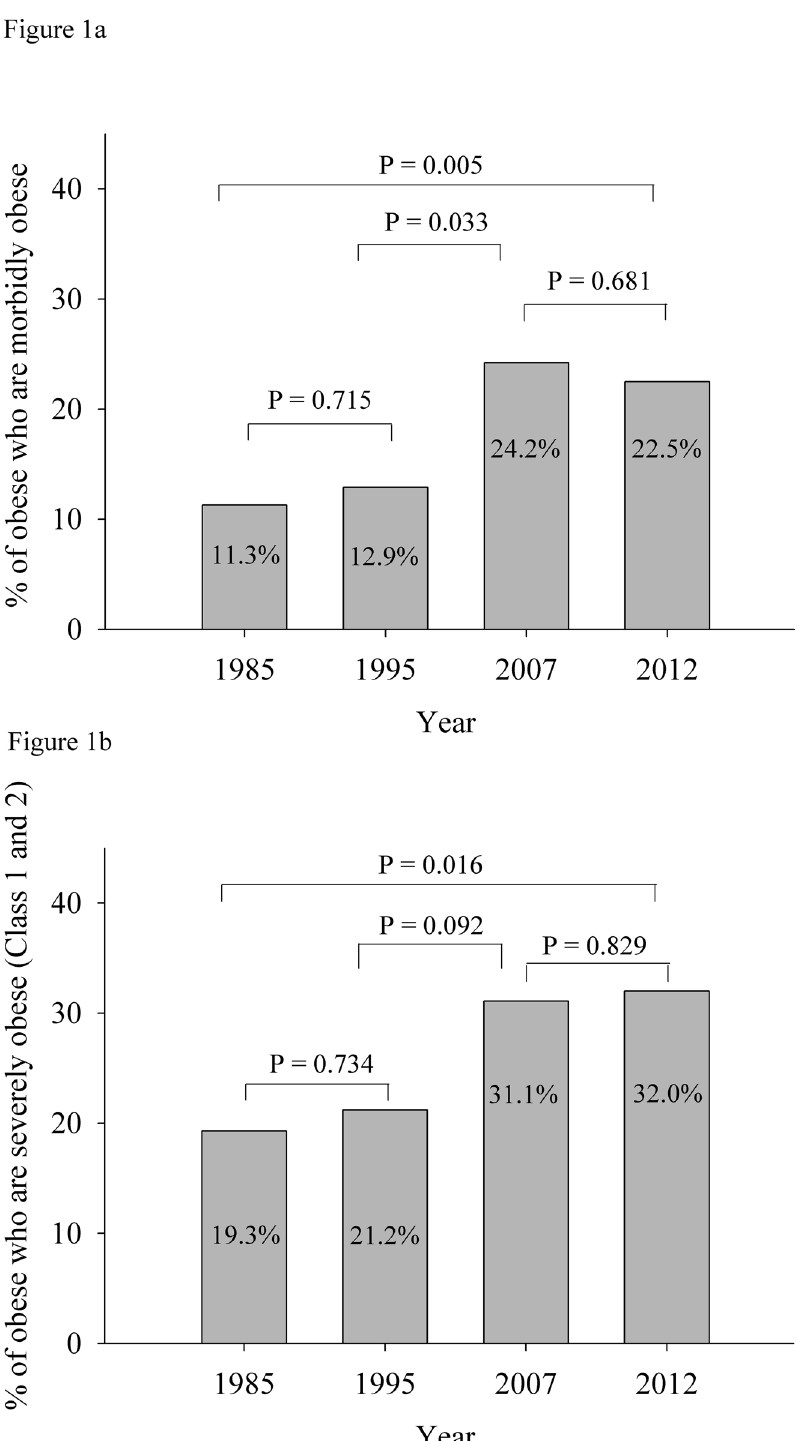
Fig 1. Prevalence of morbid obesity (Fig 1a) and prevalence of severe obesity (Fig 1b) among children with obesity 1985, 1995, 2007 and 2012. Morbid obesity was defined as age and sex adjusted BMI (cid:1) 35kg/ m 2 at 18 years) (2) and severe obesity included class 2 and 3 and was defined as BMI (cid:1) 120% 95th percentile of the CDC 2000 growth references, or a BMI (cid:1) 35kg/m 2 , whichever was lower (3).Statistical significance was determined by chi-squared